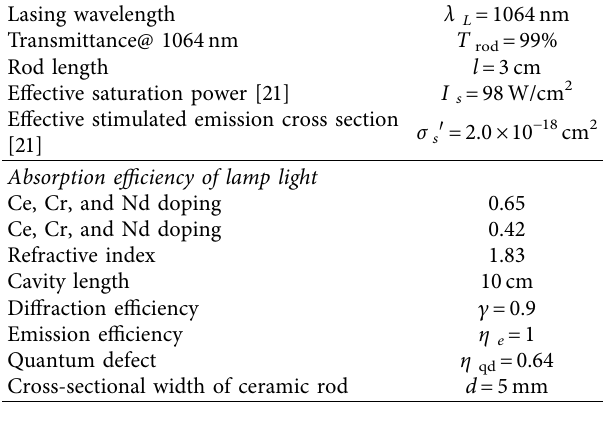
Table 1: Parameters for calculation.